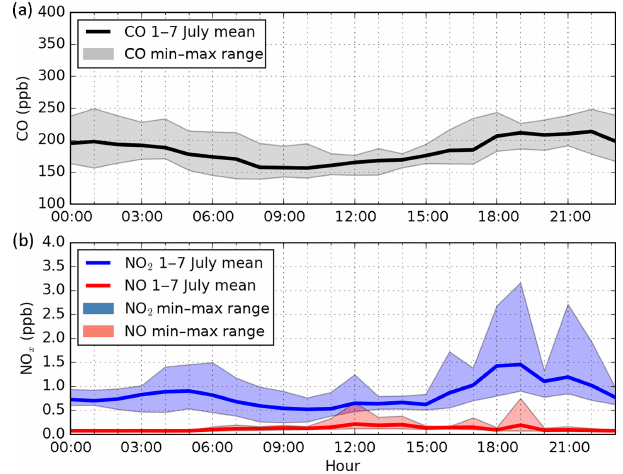
Figure 6. Hourly diurnal cycles of (a) carbon monoxide (CO in black), (b) nitrogen dioxide (NO 2 in blue), and nitrogen monox- ide (NO in red) concentrations (ppb) observed at Savè (Benin). Means of each hour are presented by the lines over the period of 1–7 July 2016 and the upper and lower shading limits correspond to the hourly ranges (maximum and minimum of each hour over the